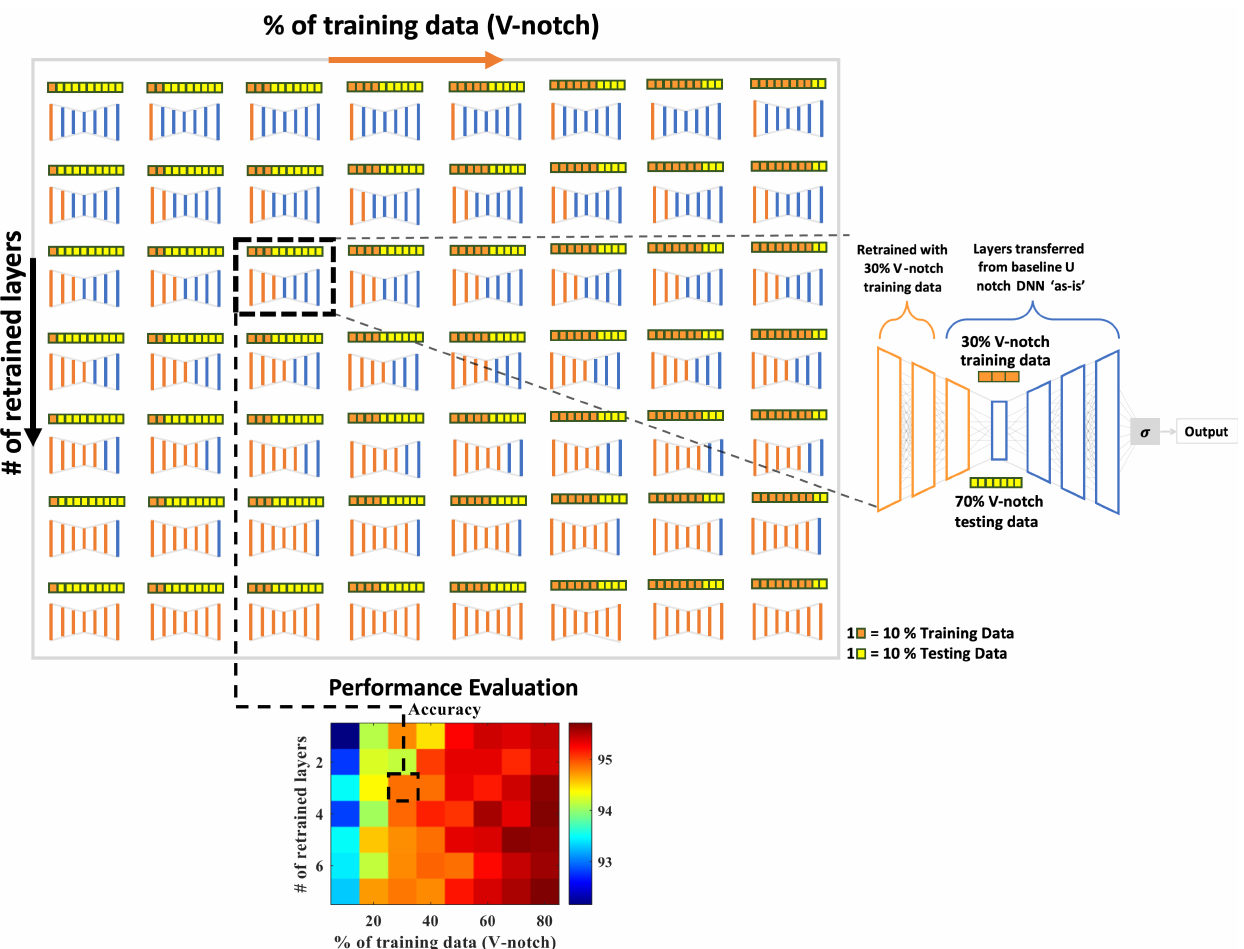
Figure 5. Overview of the parametric retraining to enable transfer learning. These DNNs have the original baseline U-notch DNN as the starting structure. Then, a fraction of the V-notch data is used to selectively train a pre-determined number of layers. Finally, the DNNs are tested on V-notch testing data to investigate the efficacy of transfer learning to enable fatigue damage detection of V-notch